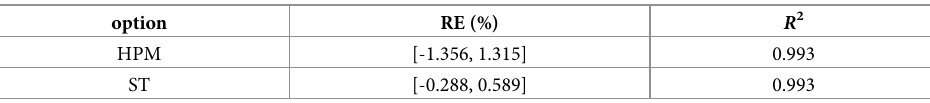
Table 4. The error analysis results of the surrogate